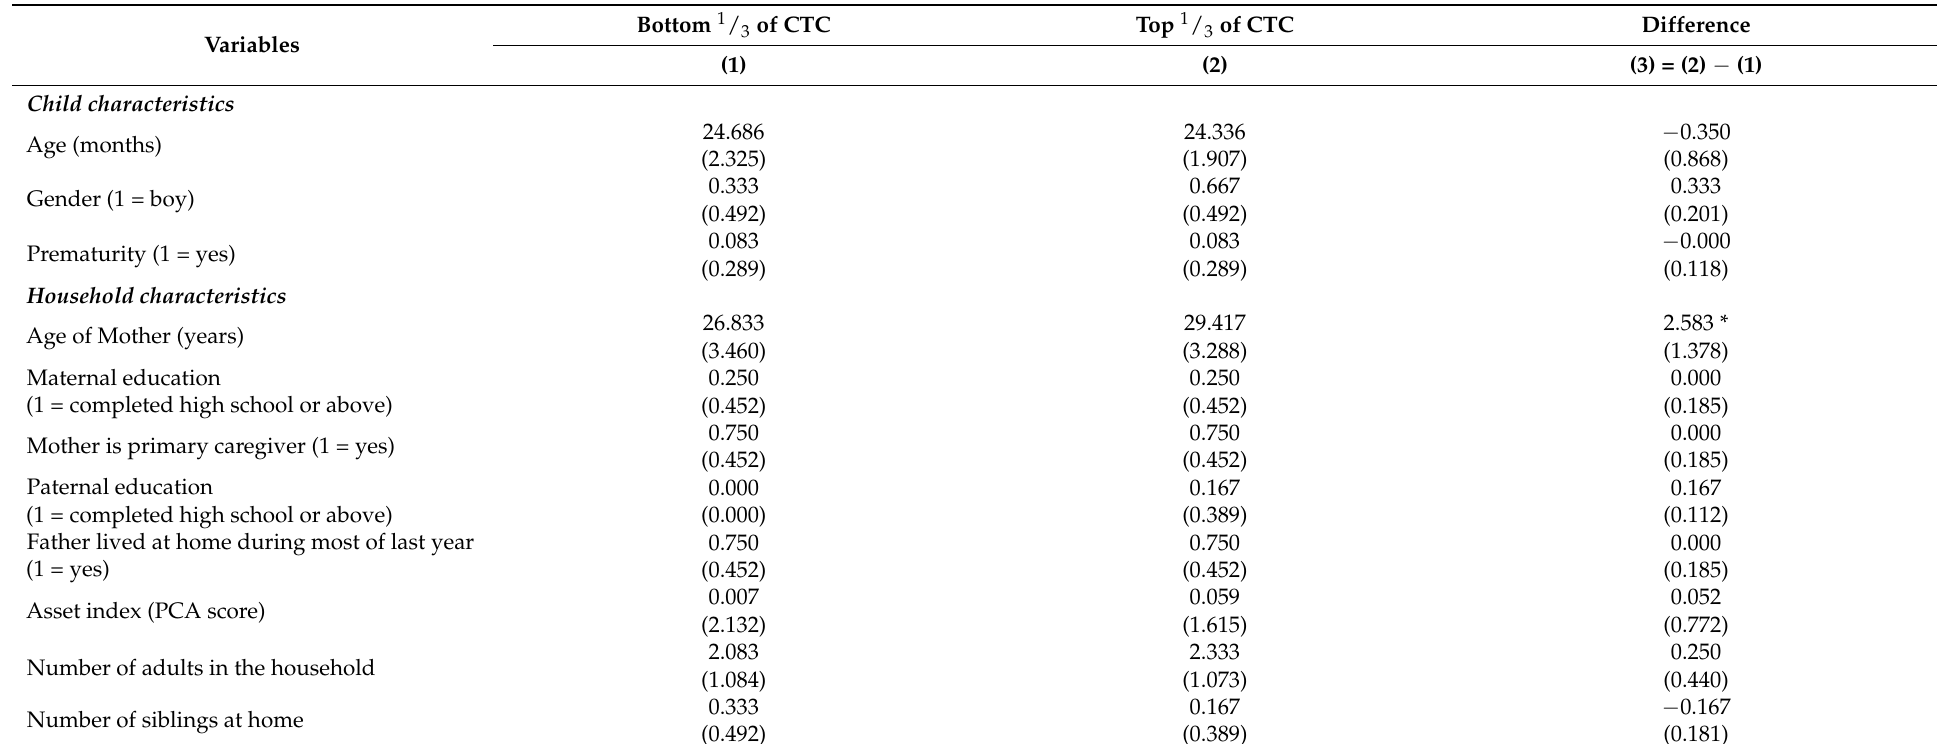
Table 3. Differences in characteristics between top and bottom terciles of Conversational Turns Count (CTC, N =